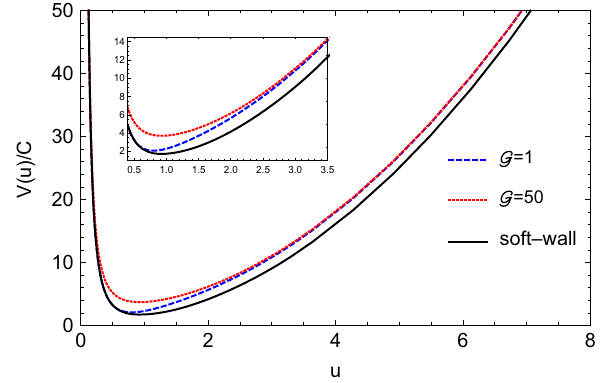
Fig. 1 The curves of the potential of Eq. (5) for two different values of G and, for comparison, the curve of the original potential in the soft- wall model [12]. The asymptotic behaviours are similar and the main difference between the models lies in the intermediate region